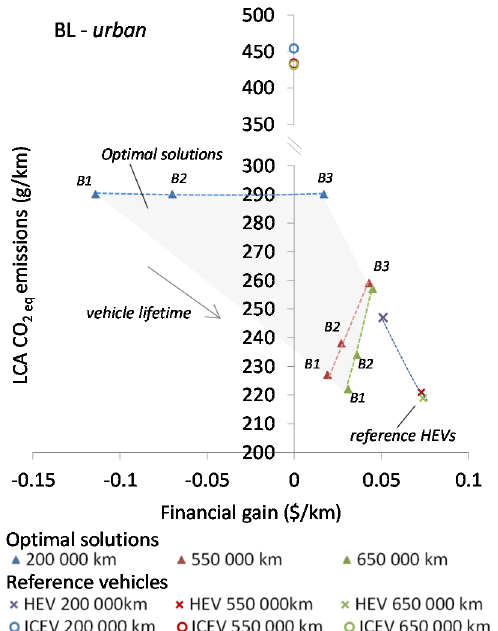
Figure 5. Set of Pareto solutions for multi-objective optimized HEVs concerning BL cycle and several life time distances, and comparison with the reference vehicles (ICEV and